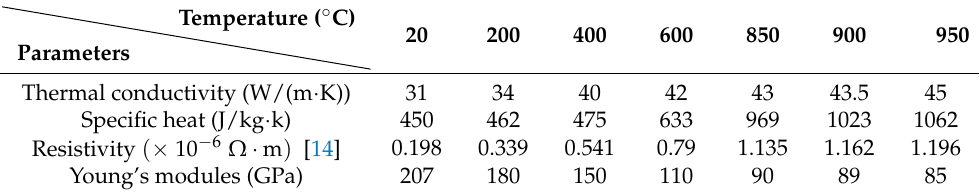
Table 2. Thermophysical parameters of B1500HS steel.